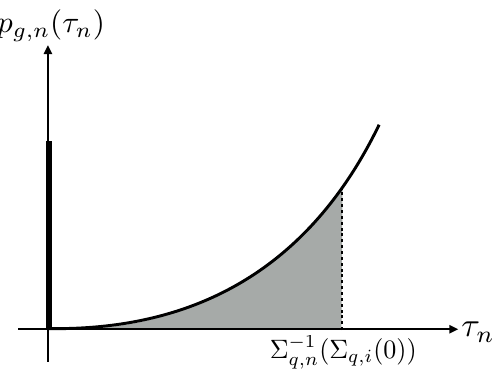
n of the gluon jet probability ((cid:6) q;i (0))). Note the (cid:14) -function at (cid:28) n = 0 for all q;n